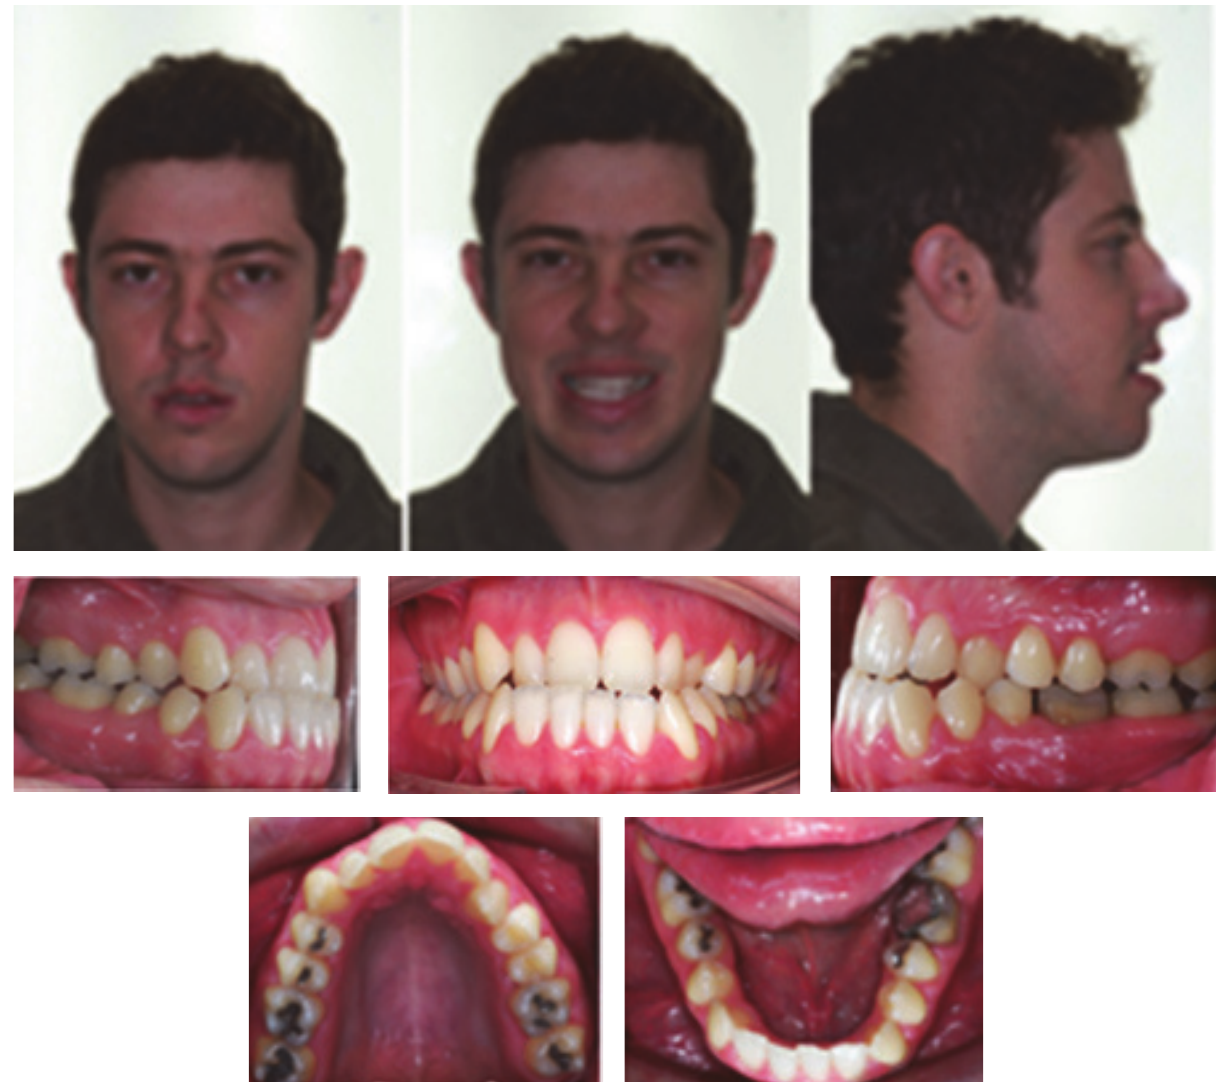
Figure 1: Pretreatment facial and intraoral photographs.